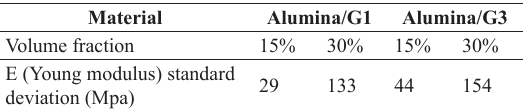
Figure 14. Young modulus obtained through computer simulation with tridimensional random RVE for the materials Alumina/G1 and Alumina/G3. Table 3. Standard deviation for the calculated Young modulus evaluated over five samples.